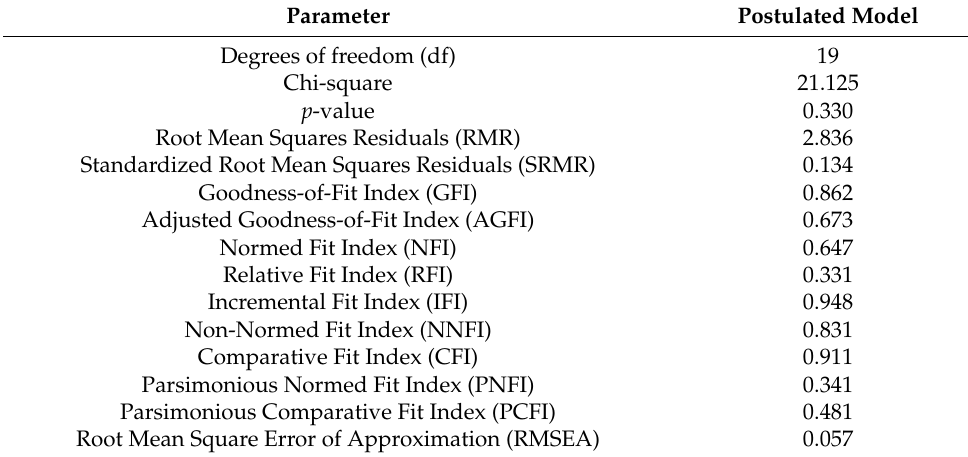
Table 3. Summary of the analyzed structural equation